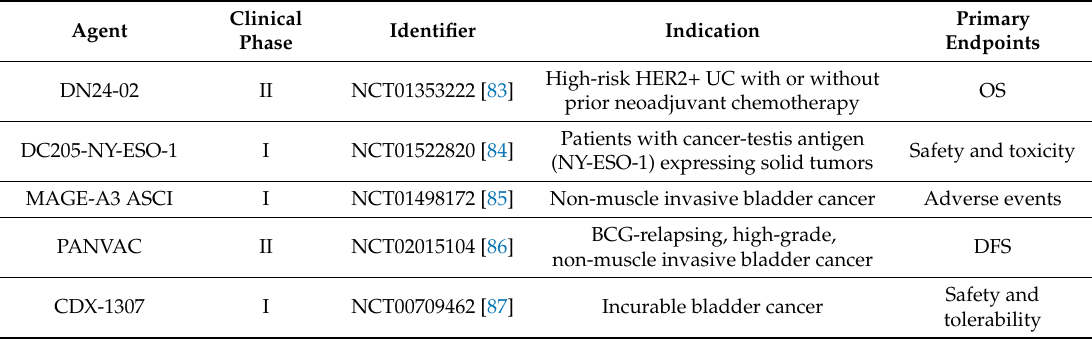
Table 7. Trials evaluating vaccine therapies for urothelial